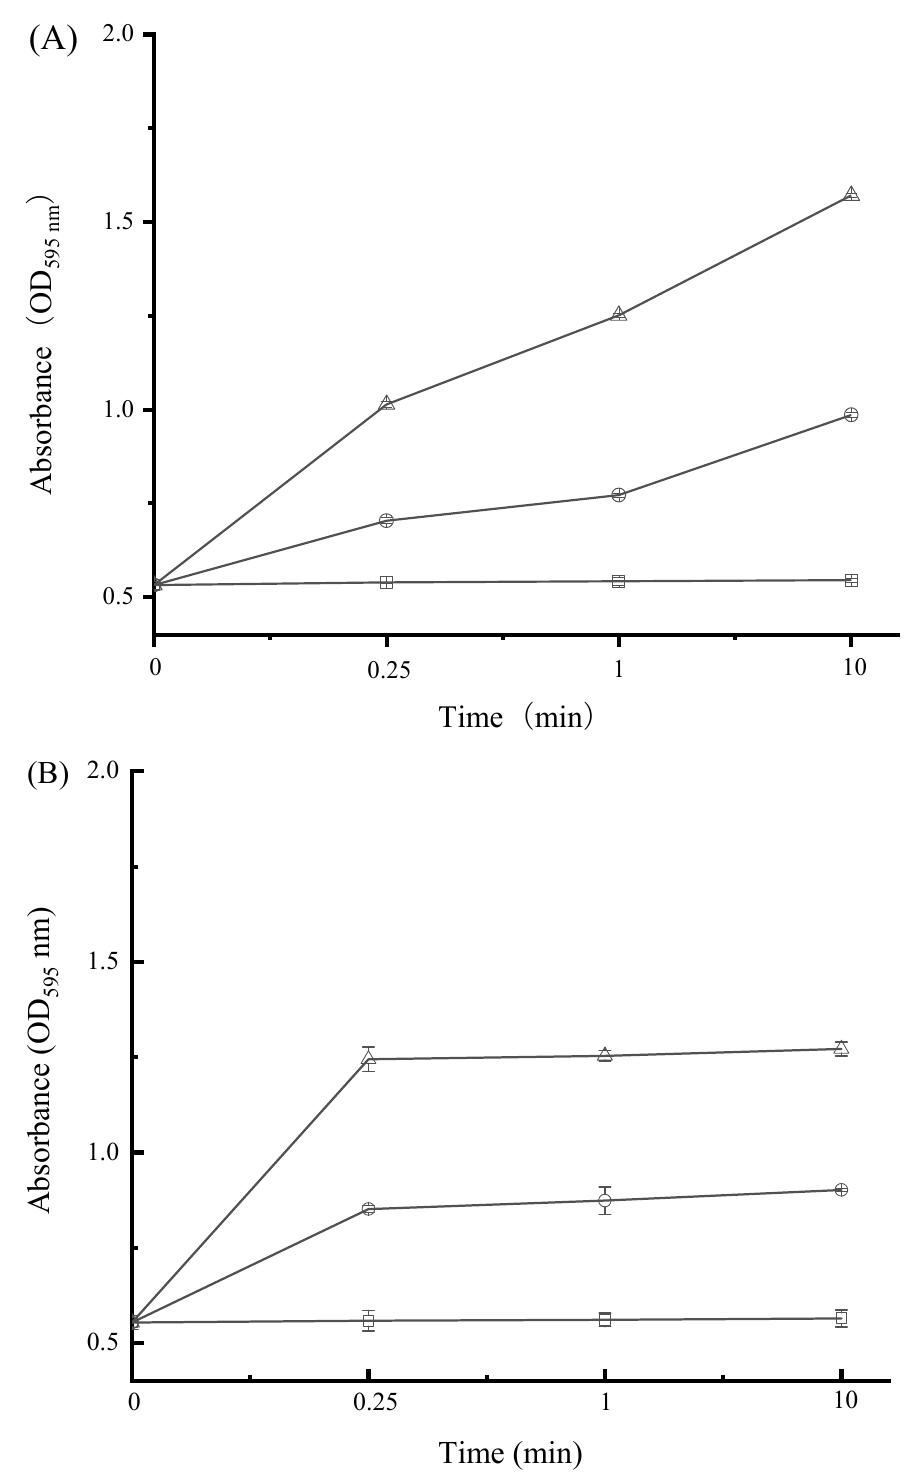
Figure 7. Effect of SAMs on the leakage of intracellular proteins in E. coli ( A ) and S. aureus ( B ) during incubation at 37 °C for 10 min. The following concentrations of SAMs were used: control ( □ ), 1/2 × MIC ( ○ ), and 1 × MIC ( △ ). Values are displayed as the mean ± standard deviation. Error bars show standard deviations, which have been plotted for all data points. Symbols without visible vertical bars suggest that the symbol size is larger than the standard deviation.